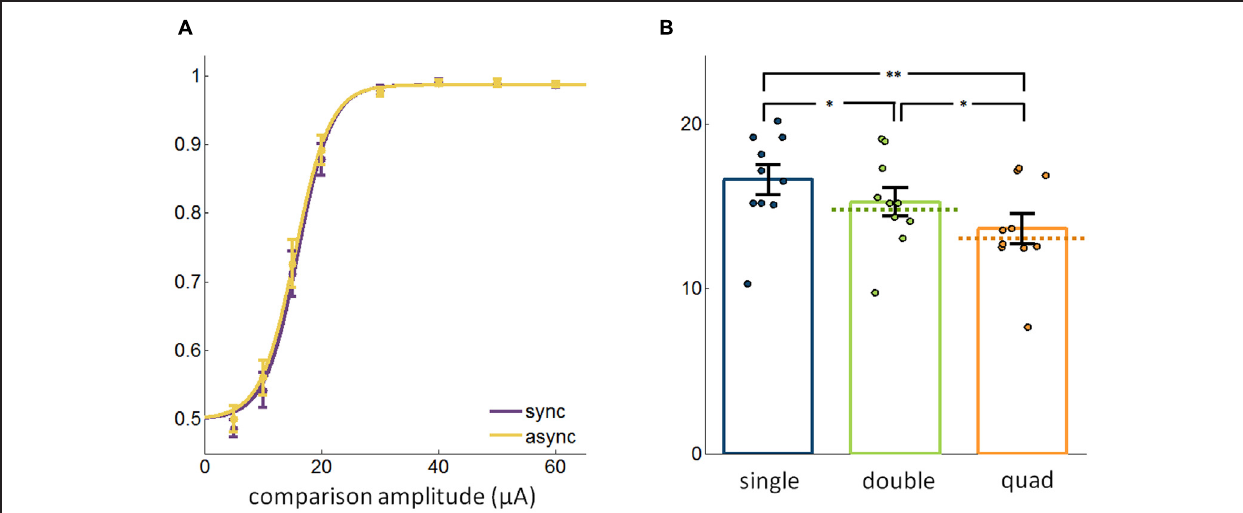
FIGURE 3 | (A) Detection performance with synchronous and asynchronous stimulation (13,202 trials from 48 electrodes). (B) Comparison of the most sensitive single electrode, best pair of electrodes, and the quad with pulses delivered asynchronously in the multi-electrode conditions (19,400 trials from 30 electrodes). Error bars denote the SE of the mean. ∗ p < 0.05, ∗∗ p < 0.01.